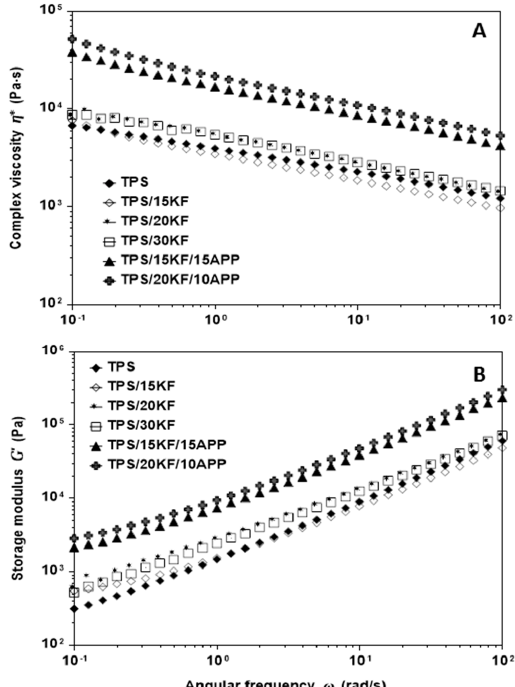
Figure 7. Complex viscosity ( A ) and storage modulus ( B ) as a function of the oscillatory frequency of TPS, TPS/KF and TPS/KF/APP composites with varied content.